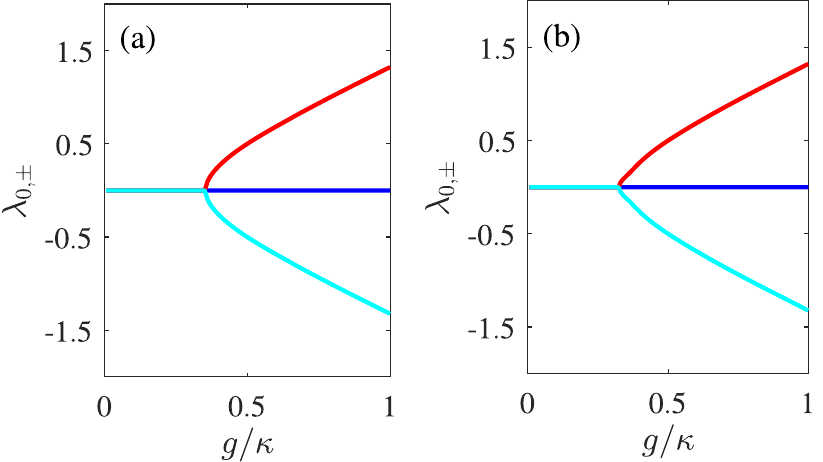
Figure 2. The bifurcation diagrams of the eigenvalues λ 0 (blue), λ + (red) and λ − (celeste) of the PT -symmetric trimer system Hamiltonian versus the cavity-QE-coupling strength g with γ = 0 in ( a ) and with = − κ = κ as a unit, other parameters κ γ = 0.025 κ in ( b ). We set κ a b chosen according to the recent experimental parameters 34